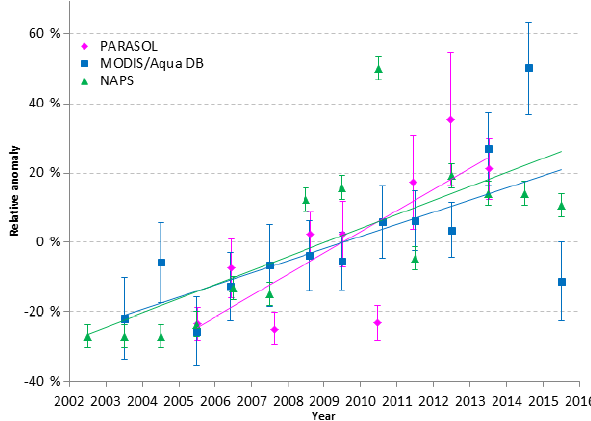
Figure 5. Relative anomalies of annual mean PM 2 . 5 mass density for the merged Albian mine and Shell Muskeg River data set, along with relative anomalies of bias-corrected annual mean AODs for POLDER/PARASOL and MODIS Aqua DB (see Sect. 3 for de- tails and Fig. 4 for satellite trend areas). Each satellite time series is plotted at the average decimal time for each calendar year. Trend lines are fitted to each time series using a matching colour. Ver- tical error bars indicate ± 1 relative standard error of the annual mean. There are, on average, 33 and 50 observations per year for POLDER/PARASOL and MODIS Aqua DB, respectively.